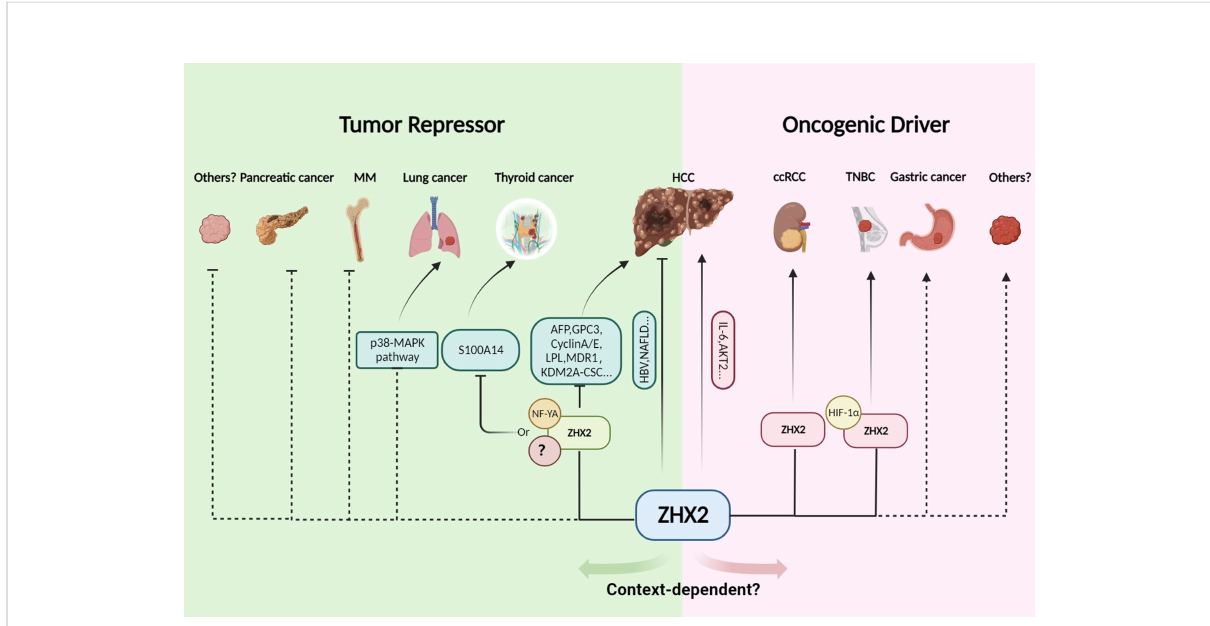
FIGURE 2 The tumor repressor or driver role of ZHX2 in cancer. In HCC, ZHX2 has a context-dependent role. ZHX2 inhibits HCC via multiple mechanisms, but whole body knockout of Zhx2 reduces DEN-induced liver tumors indicating its complex roles. In HCC, lung cancer, multiple myeloma, HL, and thyroid cancer, ZHX2 acts as a tumor suppressor and transcriptionally represses AFP, GPC3, Cyclin A/E, LPL, KDM2A, and S100A14 expression via interacting with NF-YA or other unknown partners to restrict cancer progress. However, in ccRCC and TNBC, ZHX2 plays an oncogenic driver role by interacting with p65 and HIF1 a to activate oncogenic signaling. Created using